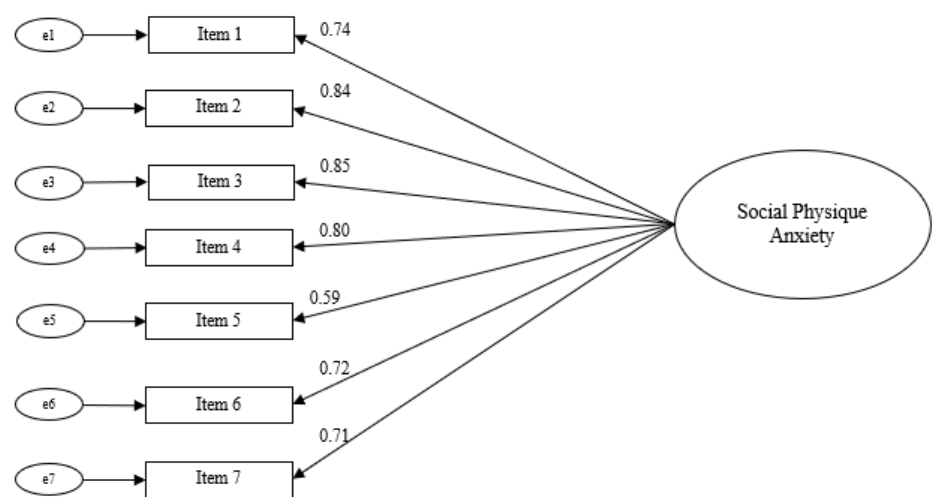
Figure 1. Confirmatory Factor Analysis Model and factor loading ( N = 520).